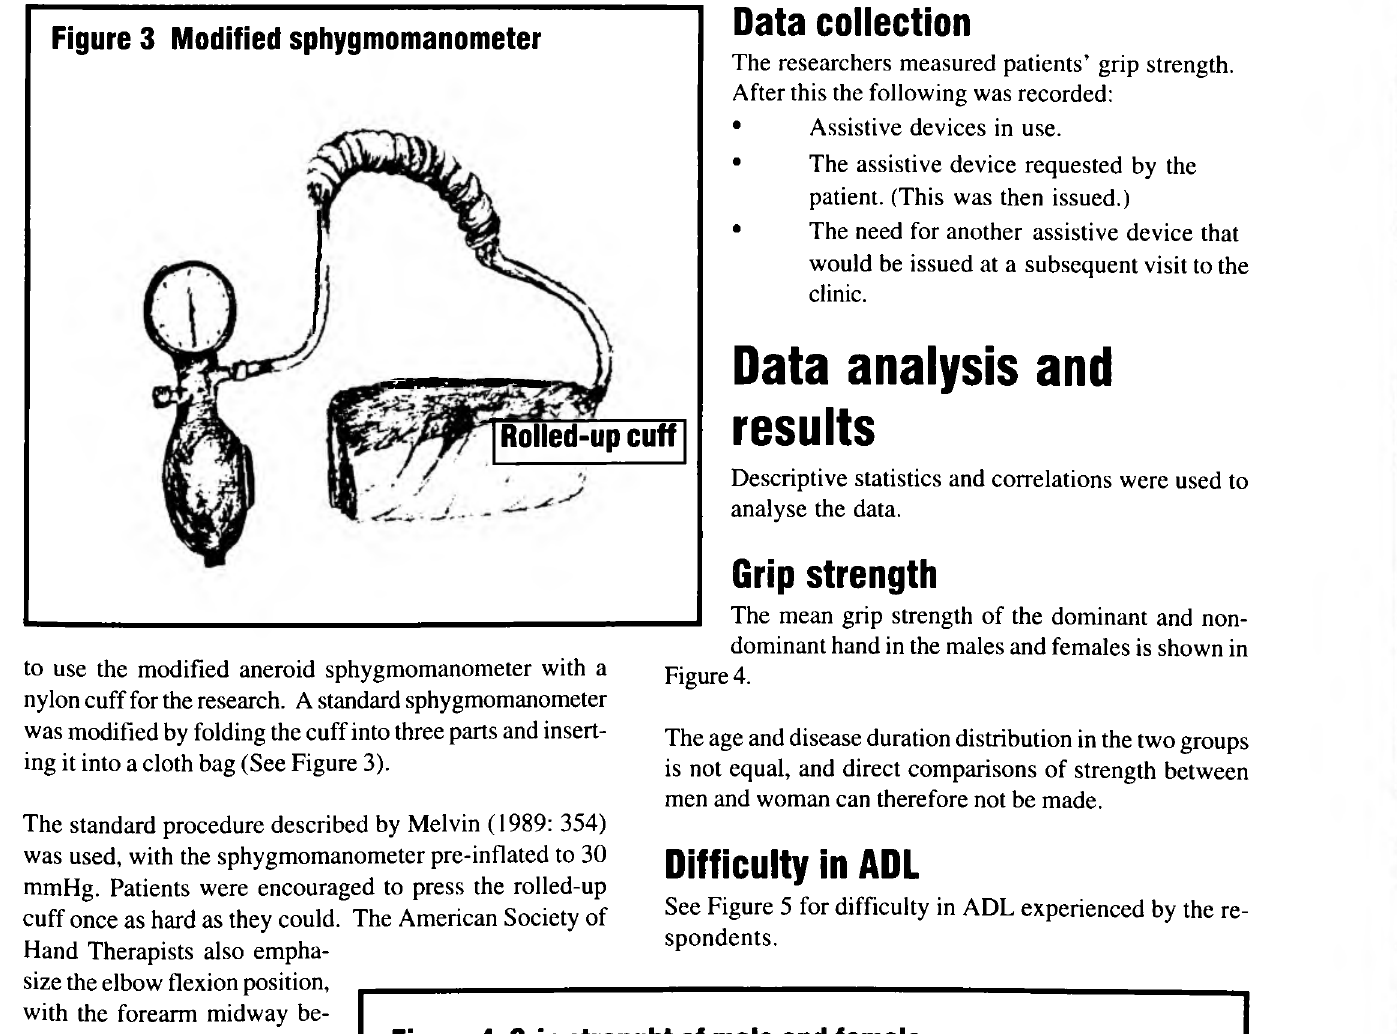
Figure 4 Grip strenght of male and